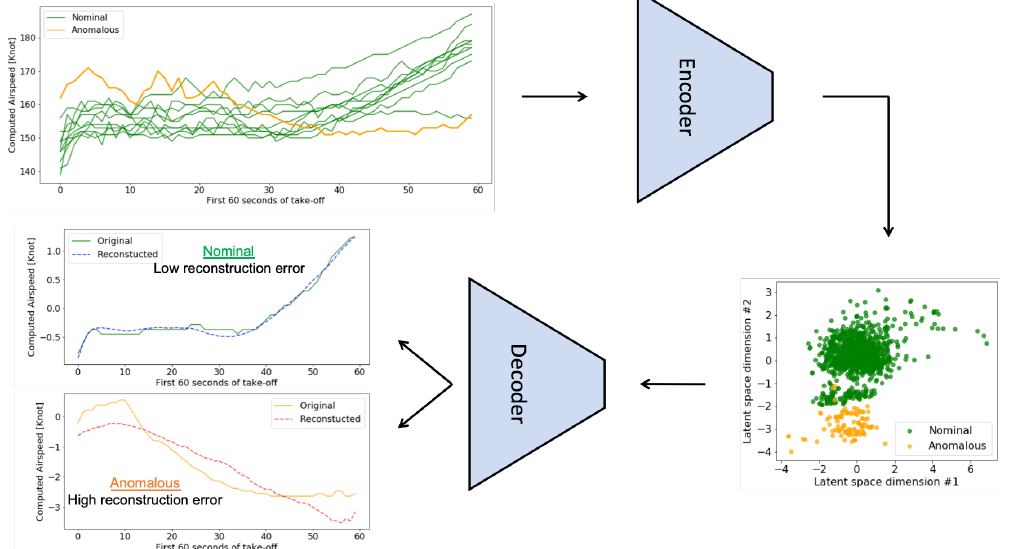
Figure 1. Overview of the proposed unsupervised anomaly detection